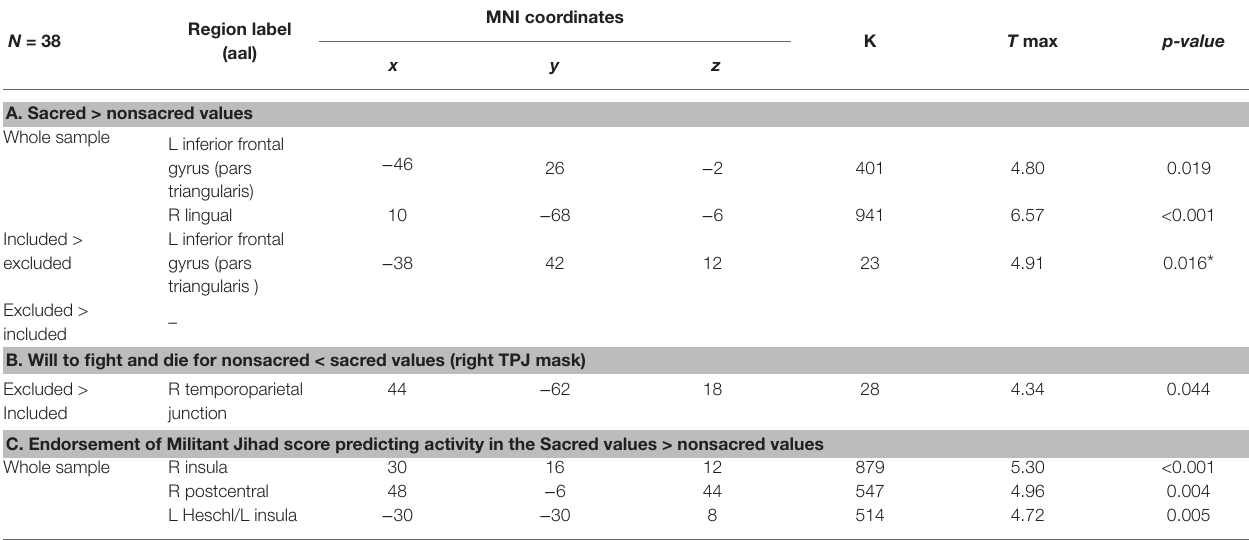
TABLE 2 | Results of the neural analysis including the within-subject sacred and nonsacred value conditions each modelled by willingness to fight and die scores as a parametric regressor and social exclusion versus nonexclusion as a between-subjects